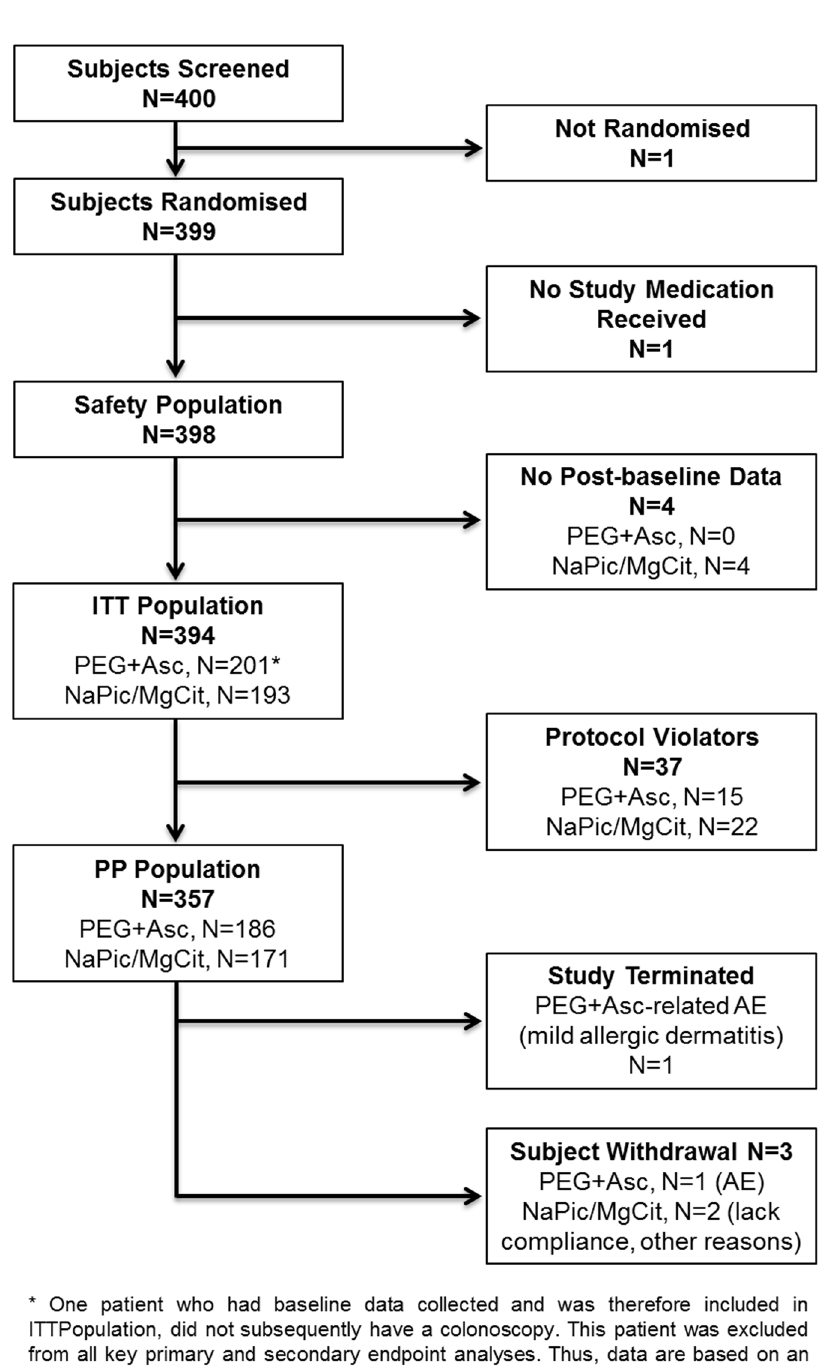
Fig 1. CONSORT diagram showing patient disposition. 800 patients. Analyses of the remaining efficacy variables were therefore performed on the data from the 394 patients who were analysed prior to the interim analysis (the ITT population). Assessments of PDR for the right and left sides of the colon were additional secondary end- points of the study. The number of patients identified as having at least one polyp on the left